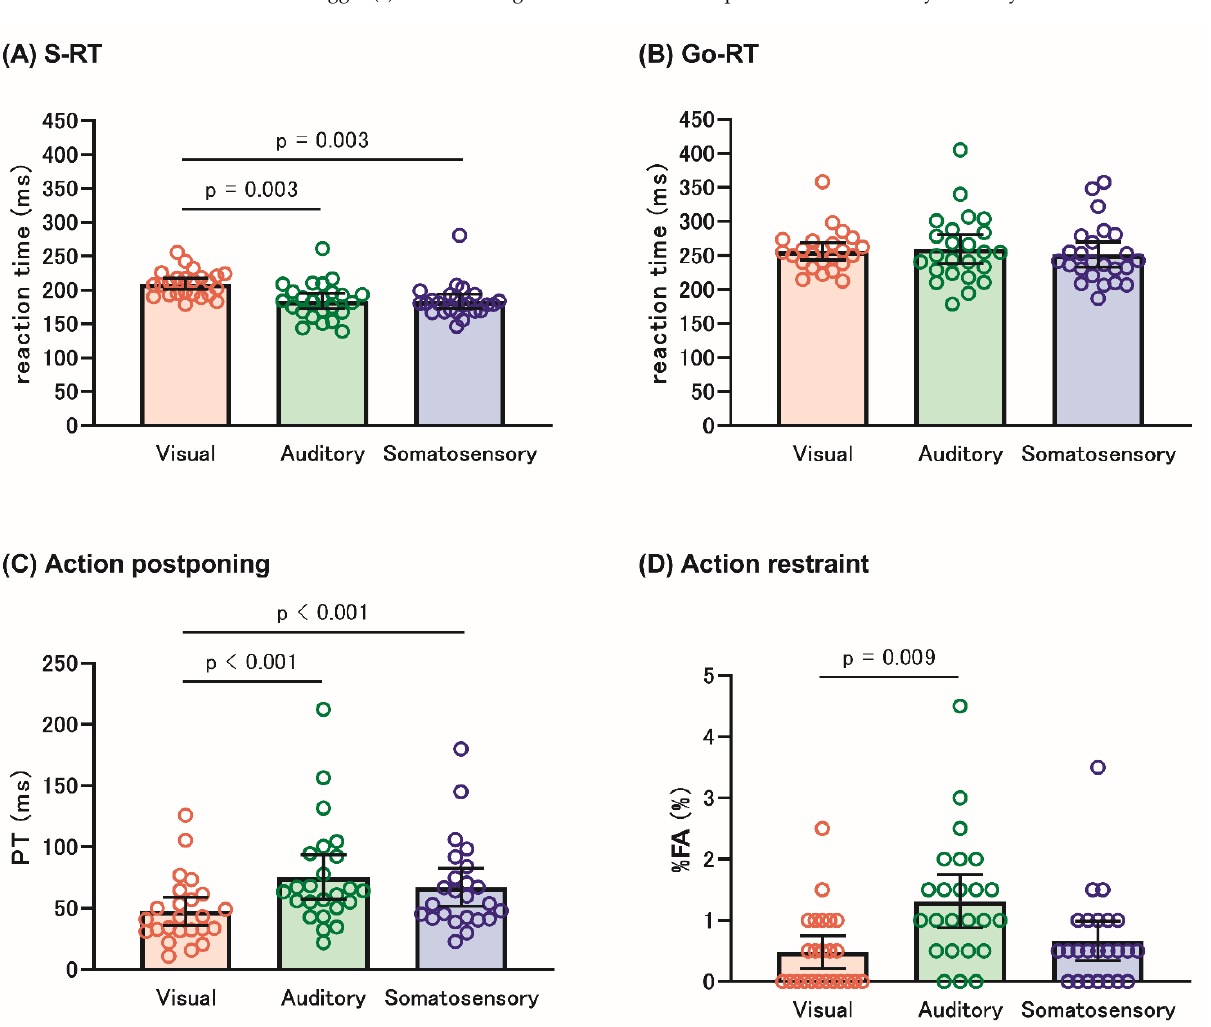
Figure 4. Behavioral data of the SRT and GNT in each modality. The top of the bar and whisker plot represents the mean value and 95% confidence interval (CI), respectively. The orange, green, and blue blocks indicate the visual, auditory, and somatosensory modalities, respectively. ( A ) The S-RT in the SRT was shorter in the visual modality than in the auditory and somatosensory modalities, while ( B ) the Go-RT in the GNT did not differ among the three modalities. ( C , D ) show the AP and AR for each modality, respectively. AP was assessed using PT, which is the difference between the S-RT and Go-RT, and AR was assessed using %FA. We demonstrated a shorter PT in the visual modality than in the other modalities and lower %FA in the visual modality than in the auditory modality. S-RT, simple reaction time; SRT, simple reaction task; Go-RT, Go reaction time; GNT, Go/No-go task; AP, action postponing; AR, action restraint; PT, postponing time; %FA, % false